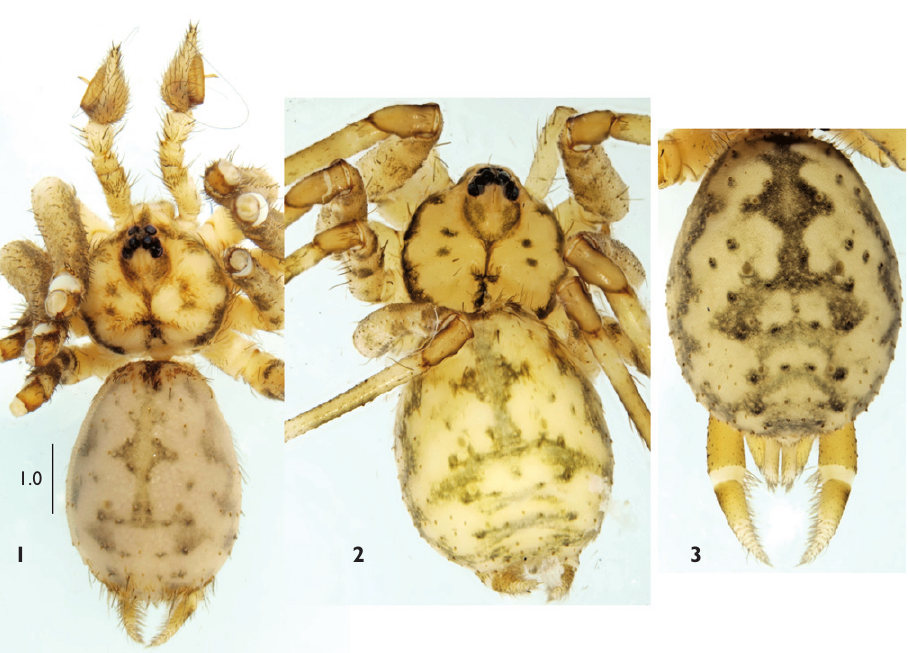
Figures 1–3. Habitus and pattern of Hersiliola turcica sp. n. 1 holotype male, dorsal 2 female from Nizip District 3 female abdomen from Harran